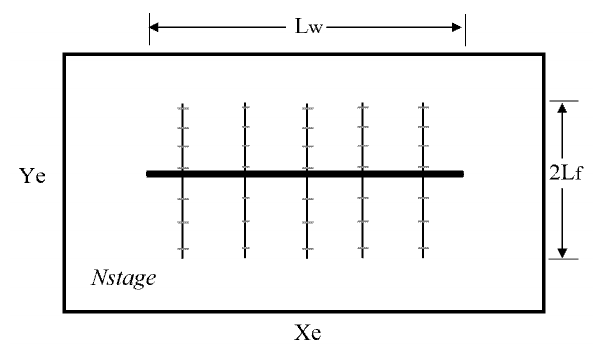
Figure 2. Schematic of reservoir-fractured horizontal well model [1].